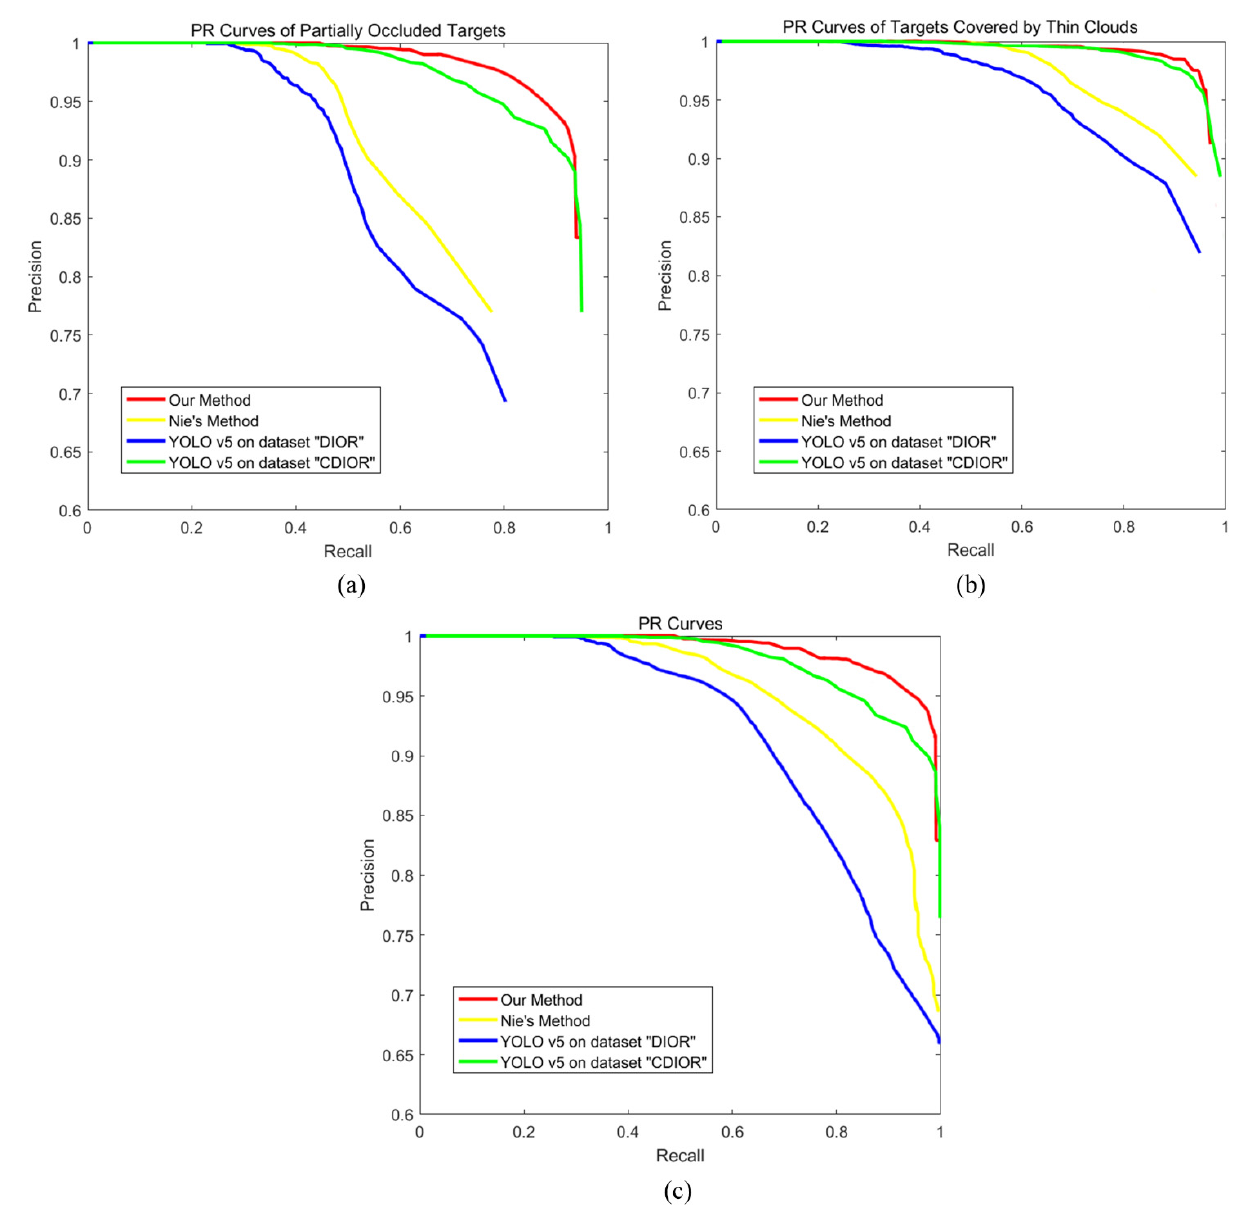
Figure 12. Comparison of PR curves of different methods: ( a ) the PR curve of the target partially occluded by thick clouds; ( b ) the PR curve of the target covered by thin clouds; ( c ) the PR curve of the overall result. We compared the method proposed by Nie [15], YOLO v5 on dataset “DIOR” and YOLO v5 on dataset “CDIOR”.